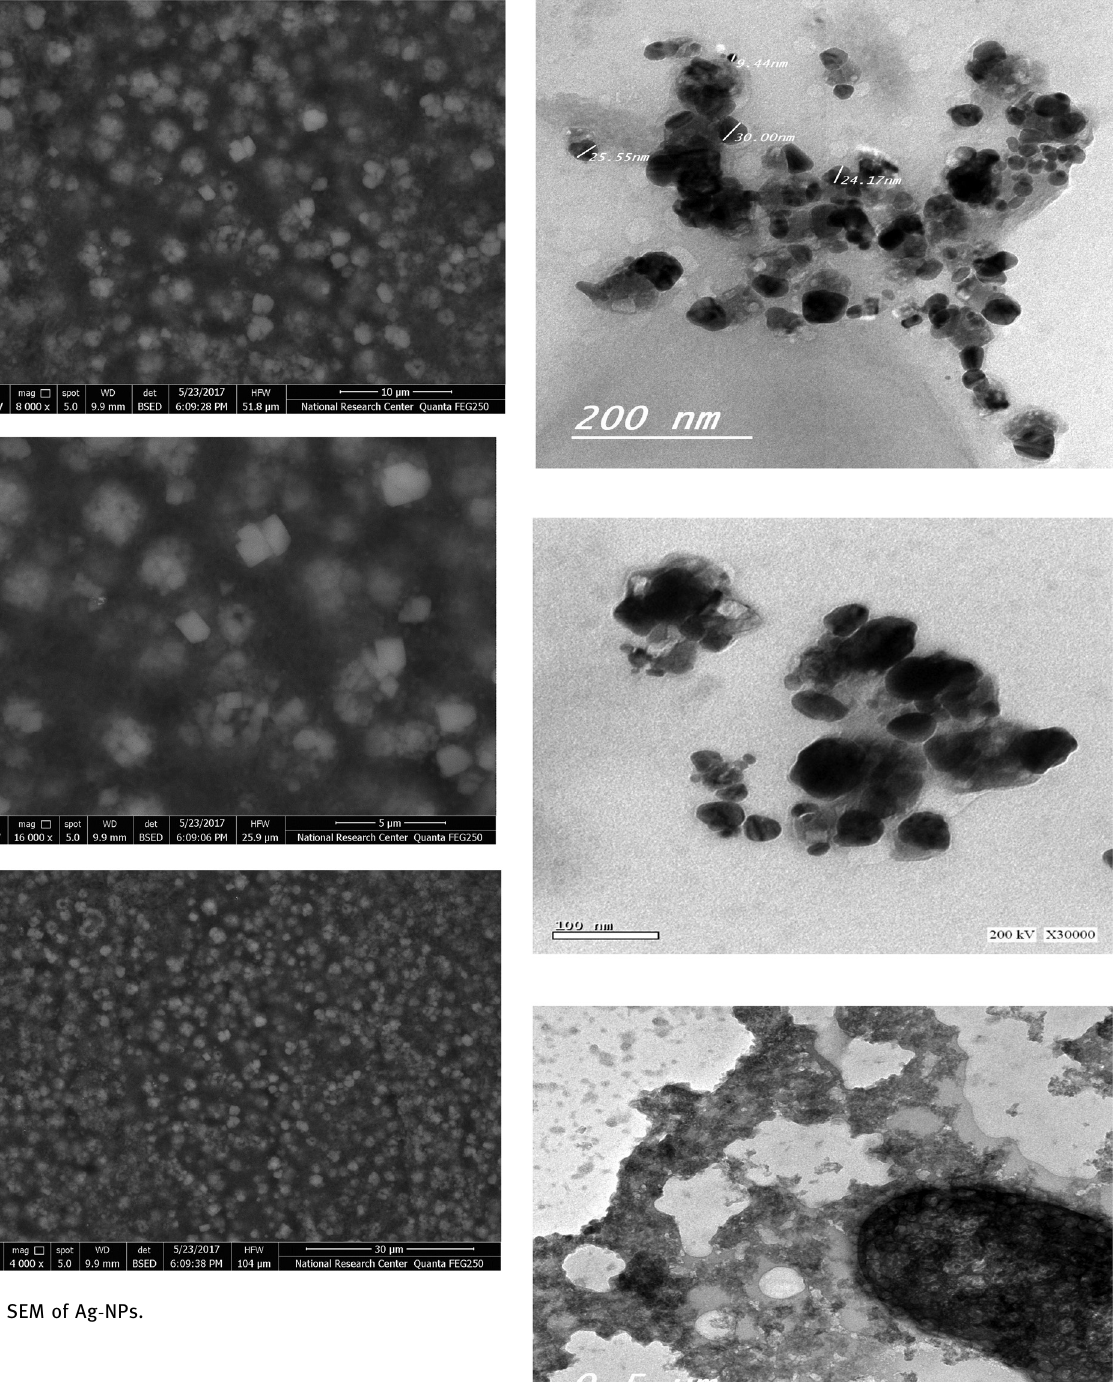
Figure 5: TEM of Ag -